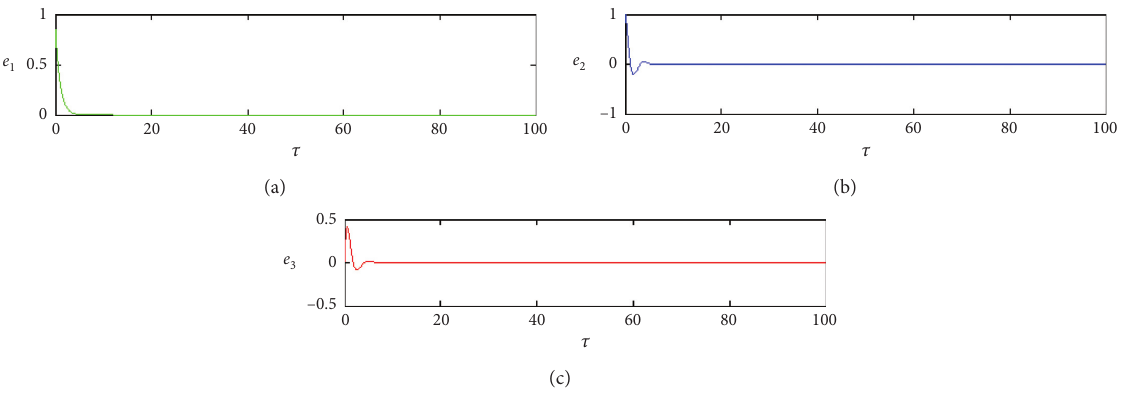
Figure 22: Temporal evolutions of the errors between the two subsystems (11) and (12) (master and slave), starting from different initial conditions: convergence of the errors (a) e 1 (in green), (b) e 2 (in blue), and (c) e